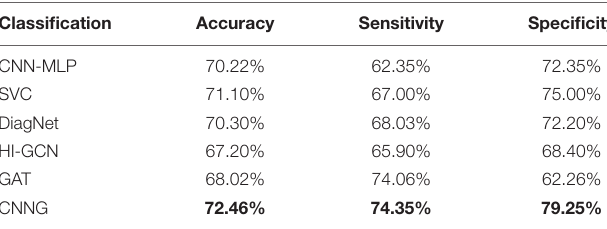
TABLE 8 | Classification performance of deep learning algorithms and CNNG.